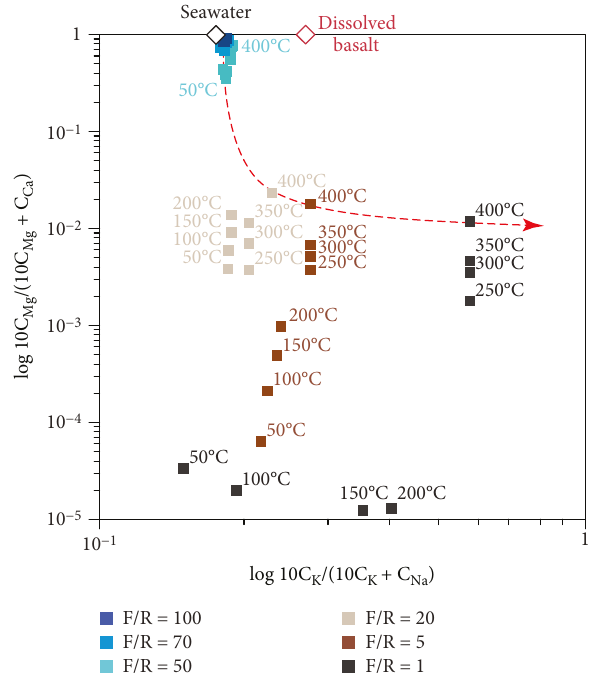
Figure 6: Plot of 10C /(10C +C ) versus log 10C /(10C + K K Na Mg Mg C ) with Ci in mmol/kg, representing the simulated Ca compositional evolution of seawater reacting with basaltic rocks at equilibrium for variable fl uid/rock (F/R) mass ratios, temperatures of 50 to 400 ° C, and at a pressure of 500 bars. Black diamond represents the composition of seawater at 2 ° C and red diamond represents the isochemical dissolution of mid-ocean ridge basalt. The dashed red curve shows the evolution of the fl uid composition from fl uid-bu ff ered to rock-bu ff ered conditions at a temperature of 400 °